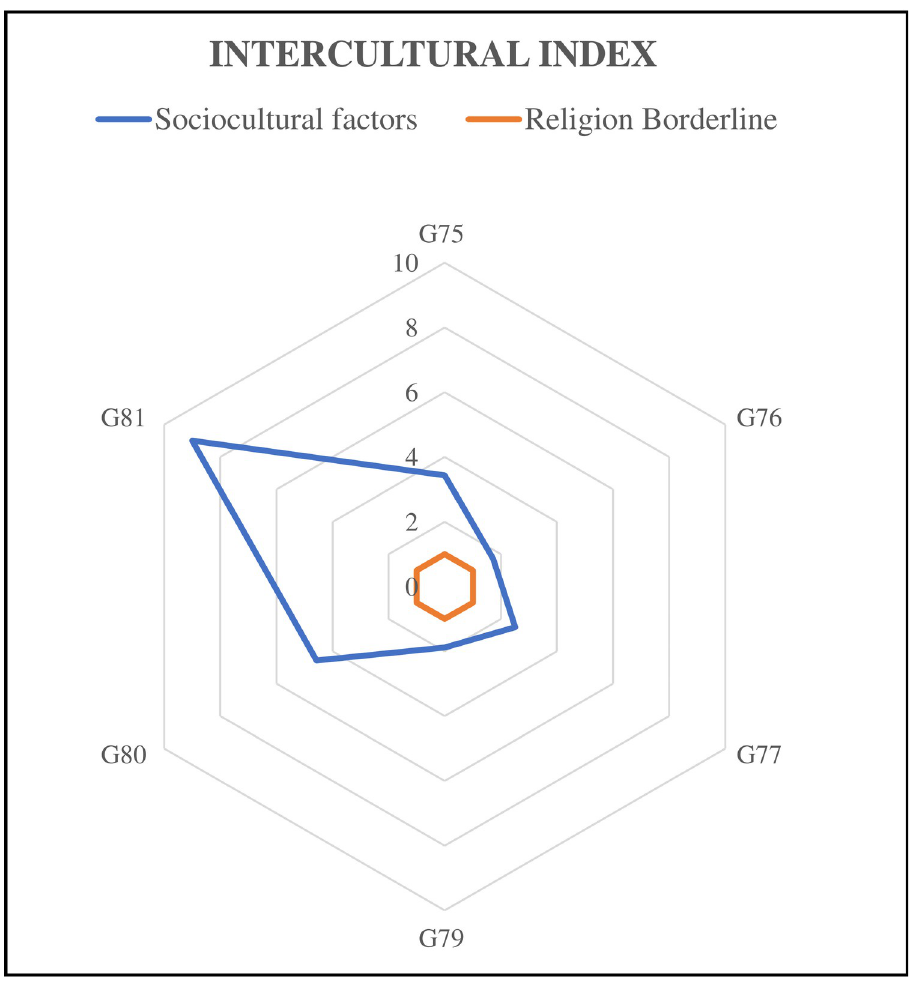
Fig 2. Data from Table 5 graphically displayed. The area of the small polygon corresponds to the expected result in the case that all Christians had similar answers in both countries. The blue polygon indicates greater differences between Catholics in both countries than differences between the two groups of Christians in the same country